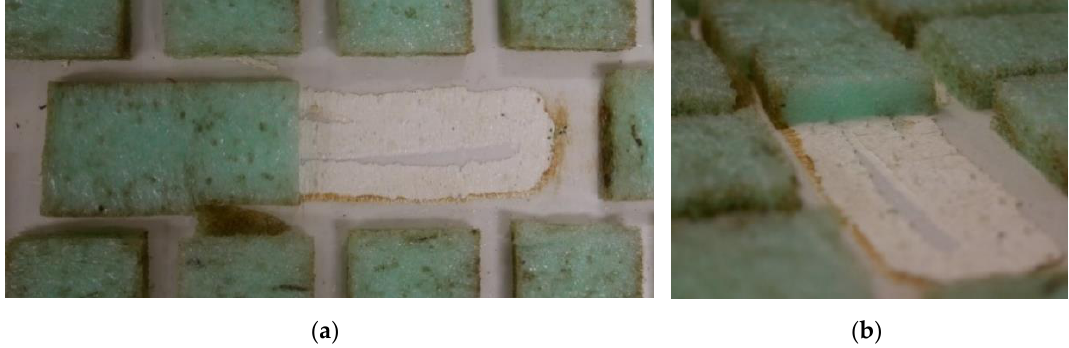
Figure 1. Cut away view showing adhesive underneath foam attached to c-Si-based flexible photovoltaic (PV) module: ( a ) top view and ( b ) orthogonal view.